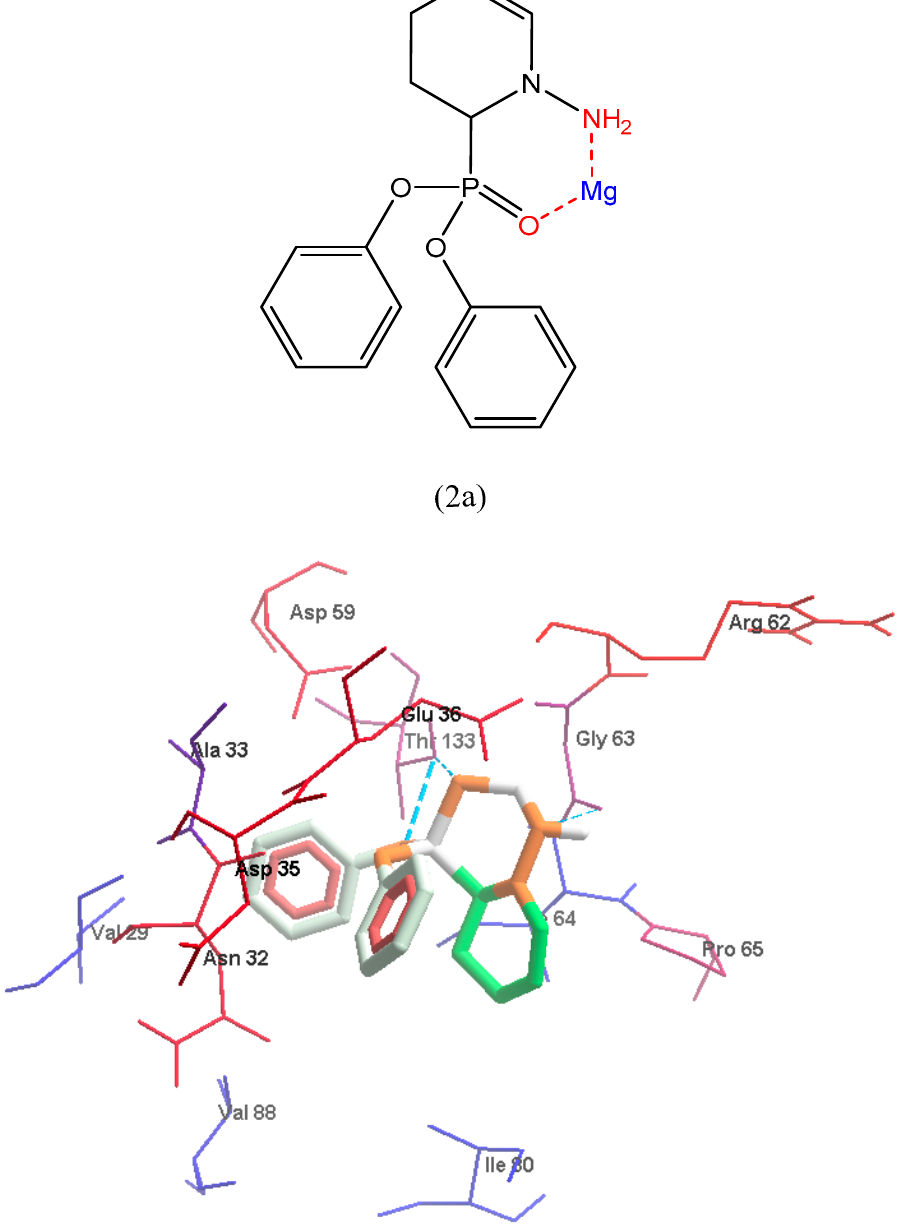
Figure 8. The first view demonstrates hydrogen bonds (blue dash), and hydrophobic interactions between 2a and gyrase B residues. The hydrophobic parts of 2a (2 light gray phenyl groups) were enclosed with red residues Asn32 and Asp35; Three hydrogen bonds (blue dash line) interaction one with NH group and Gly33 (NH-Gly63, 3 Å) besides 2 HBs with 2 oxygen atoms of phosphonate groups; Thr133(O-Thr133, 3.3 Å) and (O-Thr133, 2.8 Å). Figure 8 was mapped by Molegro Molecular Viewer, it uses the Kyte-Doolittle scale to rank amino acid hydrophobicity, where the color blue indicates the most hydrophilic, the color white is equal to 0.0, and orange-red color being the most hydrophobic. It also displays the amino acids of gyrase B as thin sticks while compound 2a atoms are represented as bold